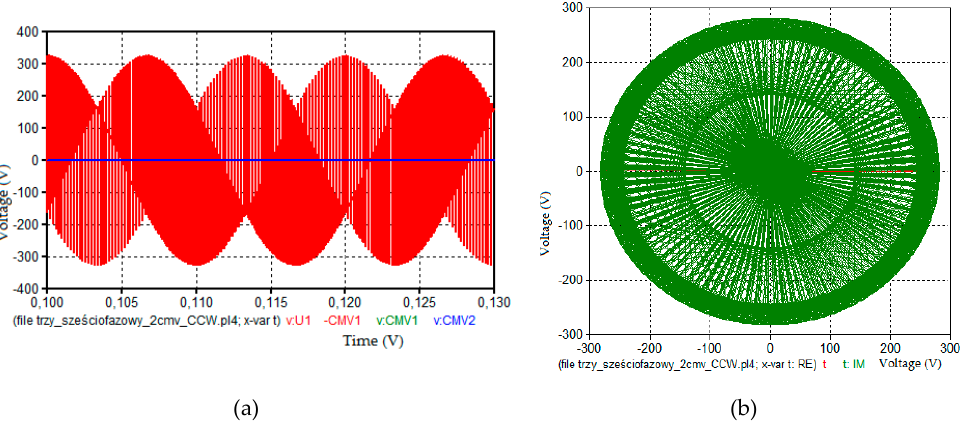
Figure 6. Waveforms of the output voltages (red lines) and the CMV (green lines) ( a ) and trajectory of the output voltage ( b ), synthesized in the MC controlled by the use of the CW rotating space vectors, for six ‐ phase load and output frequency of 30 Hz.